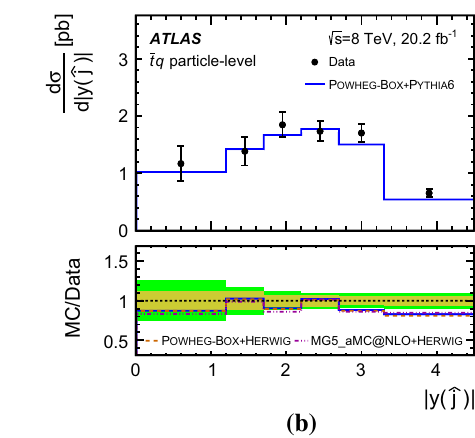
Fig. 20 Absolute unfolded differential cross-sections as a function of | y ( ˆ j ) | for a top quarks and b top antiquarks. The unfolded distributions are compared to various MC predictions. The vertical error bars on the